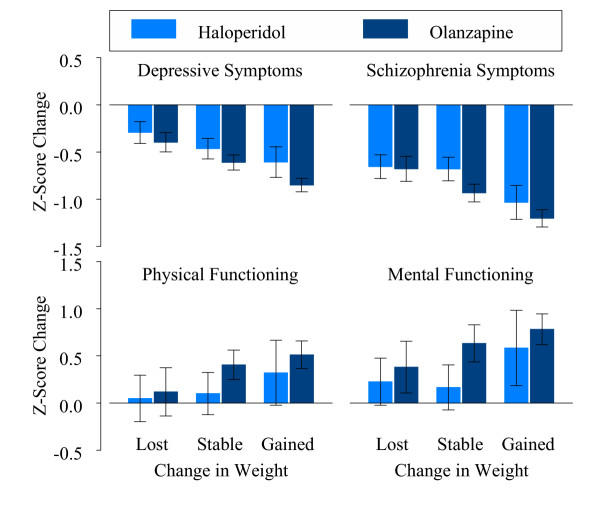
Change in outcomes by change in weight and treatment group for all patients. Patients were grouped in thirds based on their percent change in weight: "Lost" indicates any weight loss, "Stable" indicates 0% to <3% weight gain, and "Gained" indicates weight gain of 3% or more. "Depression" as measured by the MADRS or BPRS anxiety and depression scale. "Schizophrenia Symptoms" as measured by the BPRS positive symptoms and BPRS negative symptoms scales. "Physical Functioning" as measured by the SF-36 physical component score. "Mental Functioning" as measured by the SF-36 mental component score. Error bars represent 95% confidence intervals.